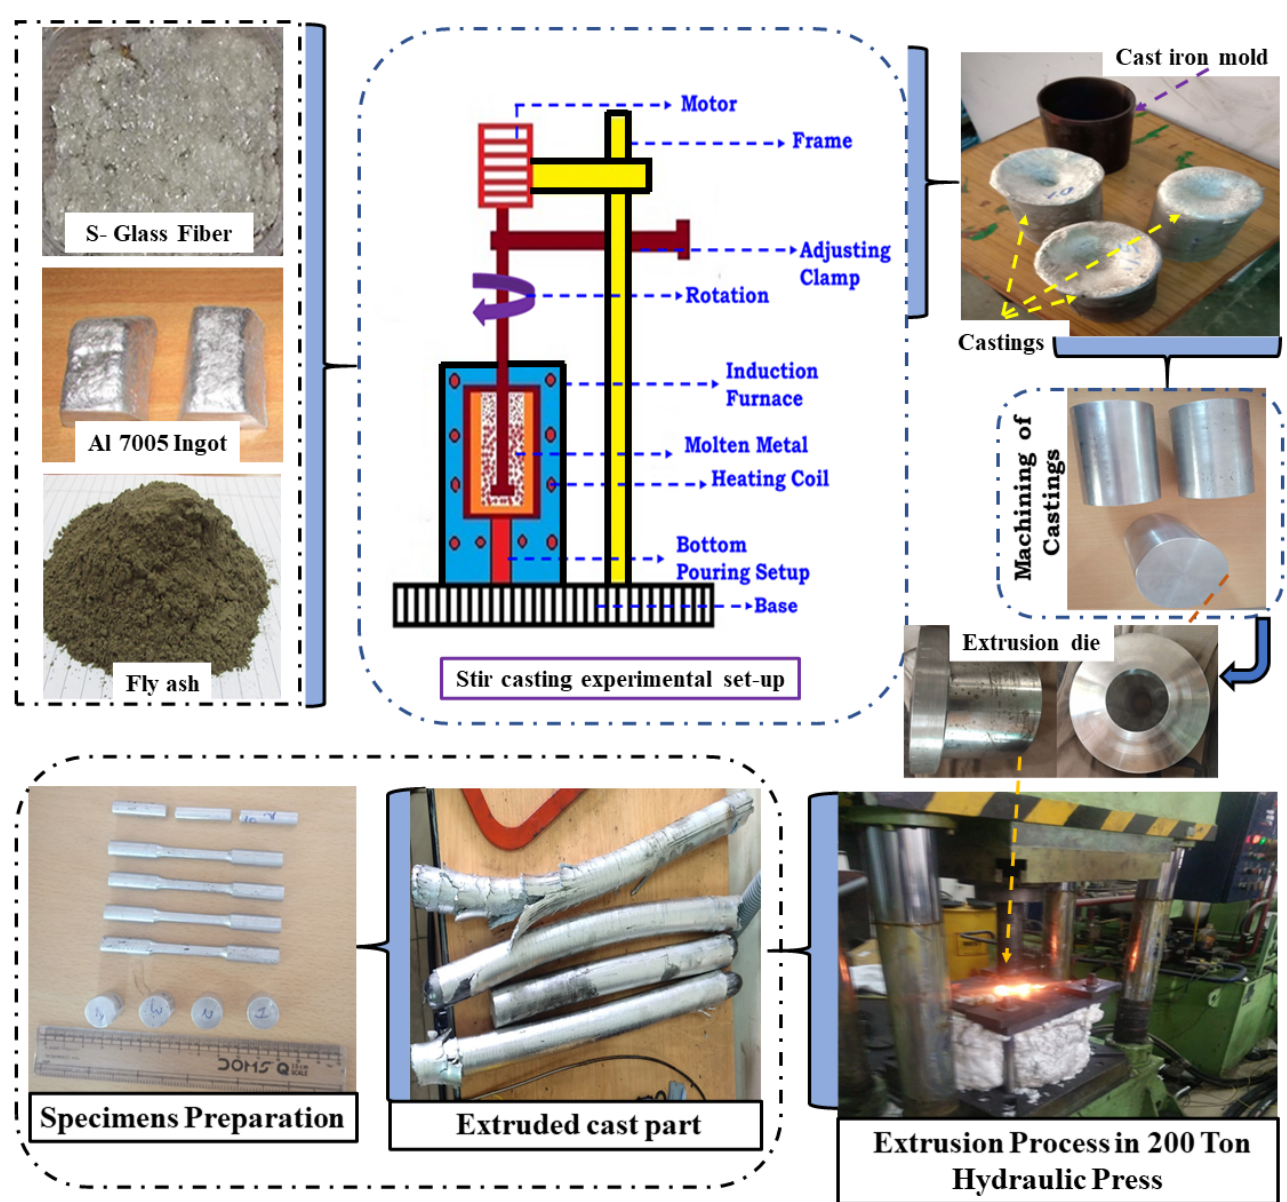
Figure 1. Flowchart illustrating the steps in fabricating the extrusion parts. Four extruded samples (for each test sample, three replicate experiments were prepared) were polished (with series of sandpapers, followed by disc polishing with 1 µ m diamond paste) and cleaned with water followed by acetone. Later, the specimens were air-dried. The polished specimens were etched with Keller’s solution (H 2 O + HNO 3 + HF + HCl) to reveal the microstructure viz. scanning electron microscope. The framework of specimen preparation and characterization is presented in Figure